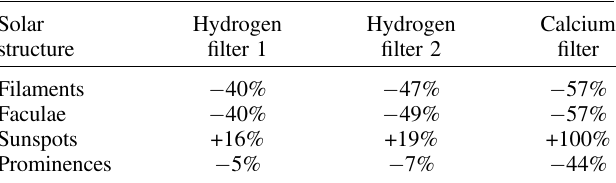
Fig. 4. Simulation of typical data that will be produced by the MeteoSpace instrument. Top (left to right): H a core and H a blue wing ( (cid:4) 0.5 Å). Bottom (left to right): composite H a image showing enhanced structures (line center minus blue wing) and CaII K. Table 2. Contrast loss of MeteoSpace structures compared to the Spectroheliograph at line